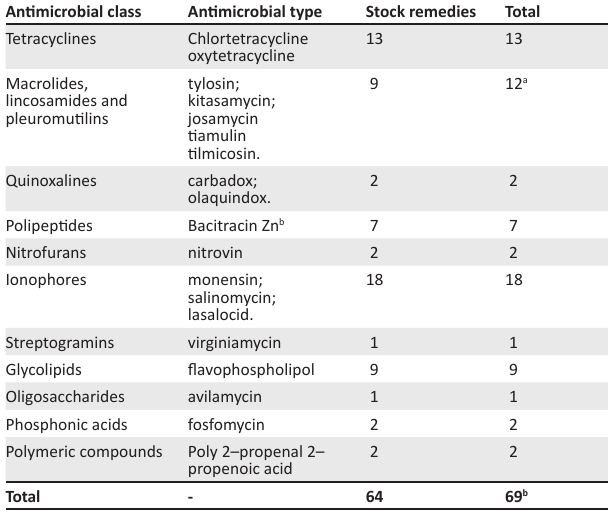
TABLE 1: Number of in-feed (premixes) antimicrobial products authorised for growth promotion in food animals in South Africa. Antimicrobial class